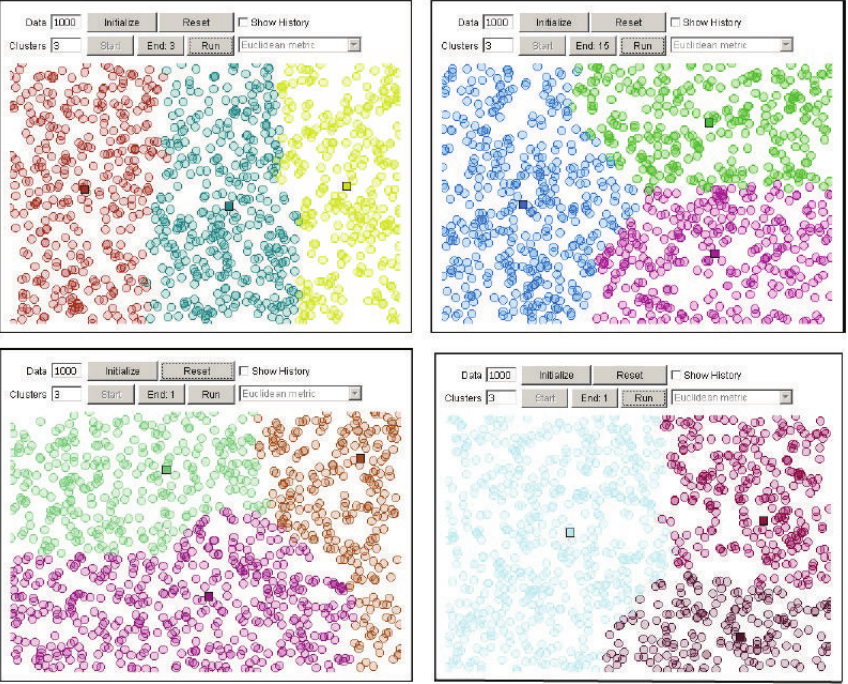
Figure 1: Examples of clustering results by random centroids of K-means where 𝑘 = 3